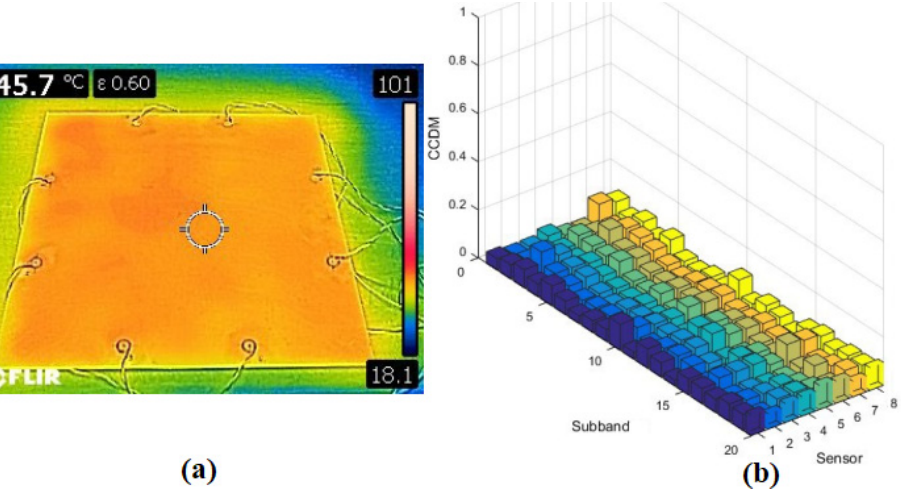
Figure 3. ( a ) Thermal image of the uniformly heated structure; ( b ) CCDM indices calculated after compensation with the EFS method. compensation with the EFS